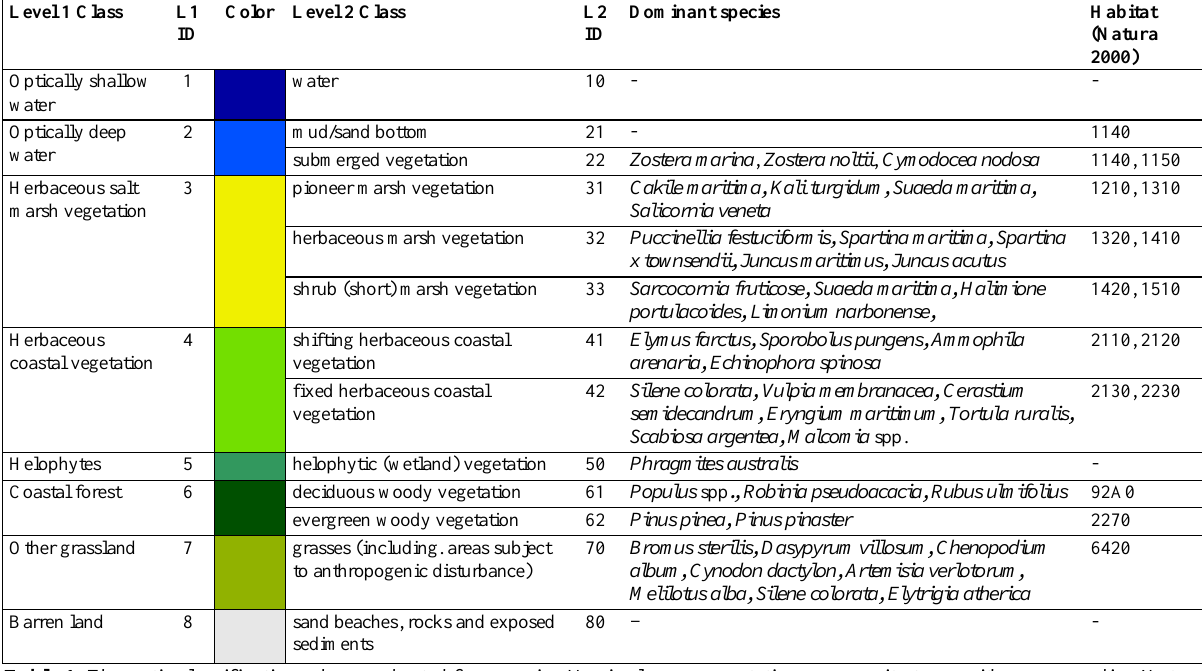
Table 1 . Thematic classification scheme adopted for mapping Venice lagoon vegetation community type, with corresponding Natura 2000 habitat nomenclature and dominant species present for each